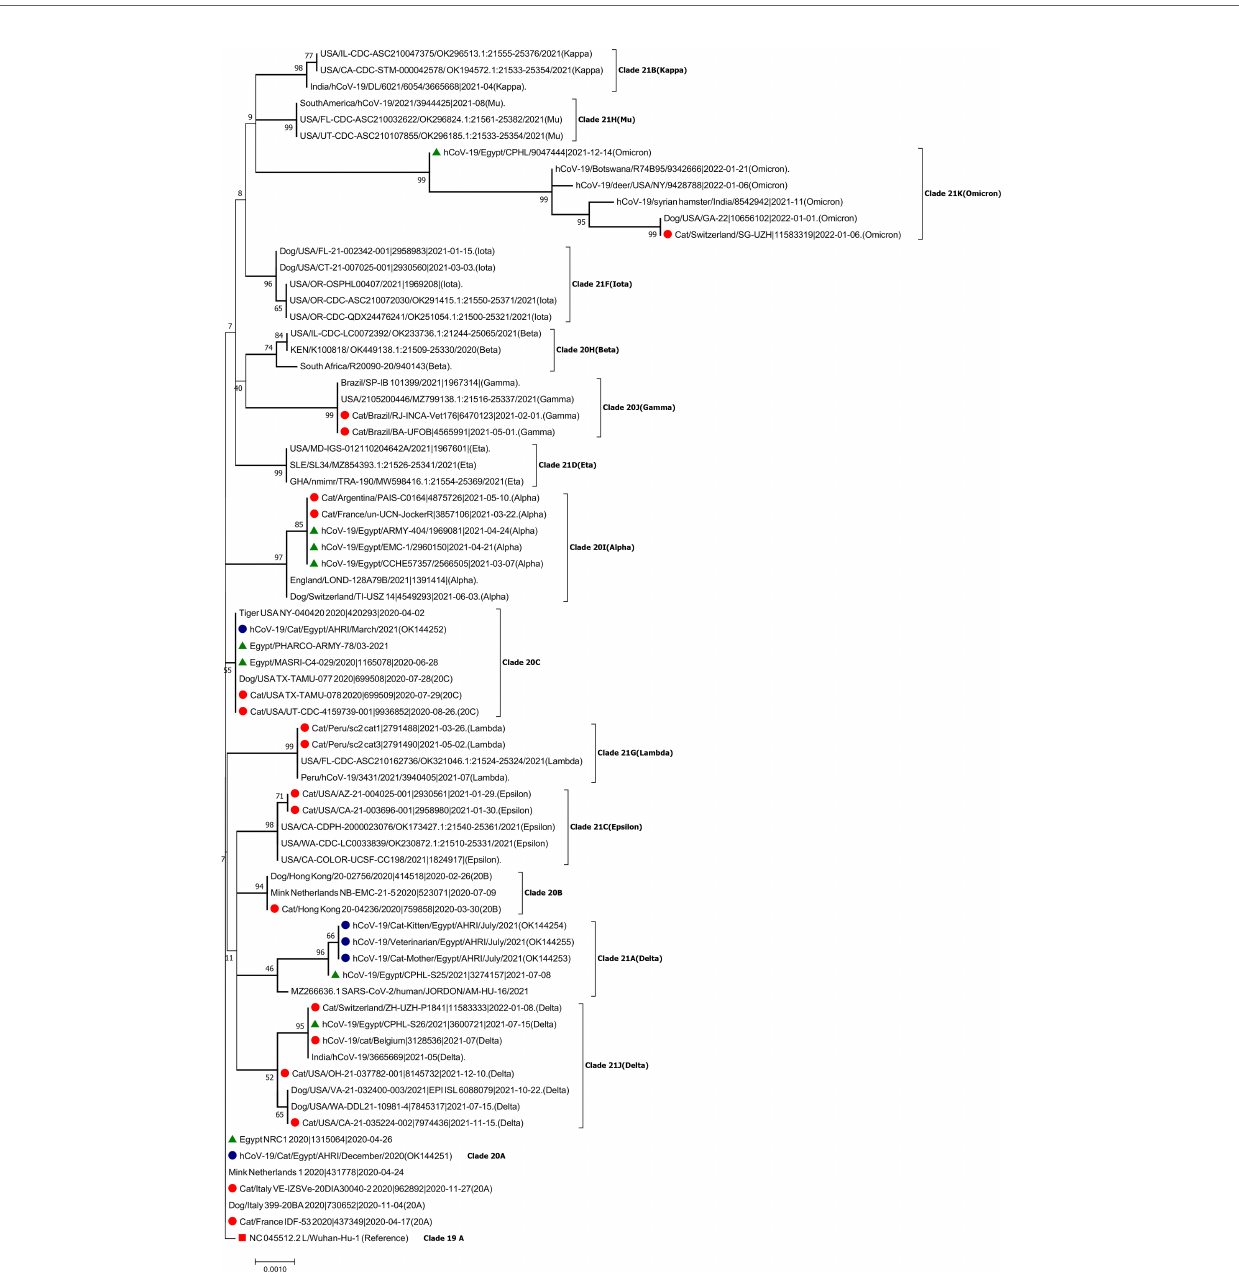
FIGURE 3 | Phylogentic analysis of the SARS-CoV-2 sequences. The rooted maximum likelihood tree shows the relationship between sequenced samples and current circulating variants in humans and animals in which the related taxa and closed branches are clustered together illustrating SARS-CoV-2 evolution. The blue circles illustrate the sequenced SARS-CoV-2 that were detected in cats in the present study while the red circles display the detected SARS-CoV-2 in cats worldwide from 2020 till January 2022. The green triangles depict circulating SARS-CoV-2 strains in Egypt within the same time frame. The red square refers to SARS-CoV-2 Wuhan-Hu-1 human reference